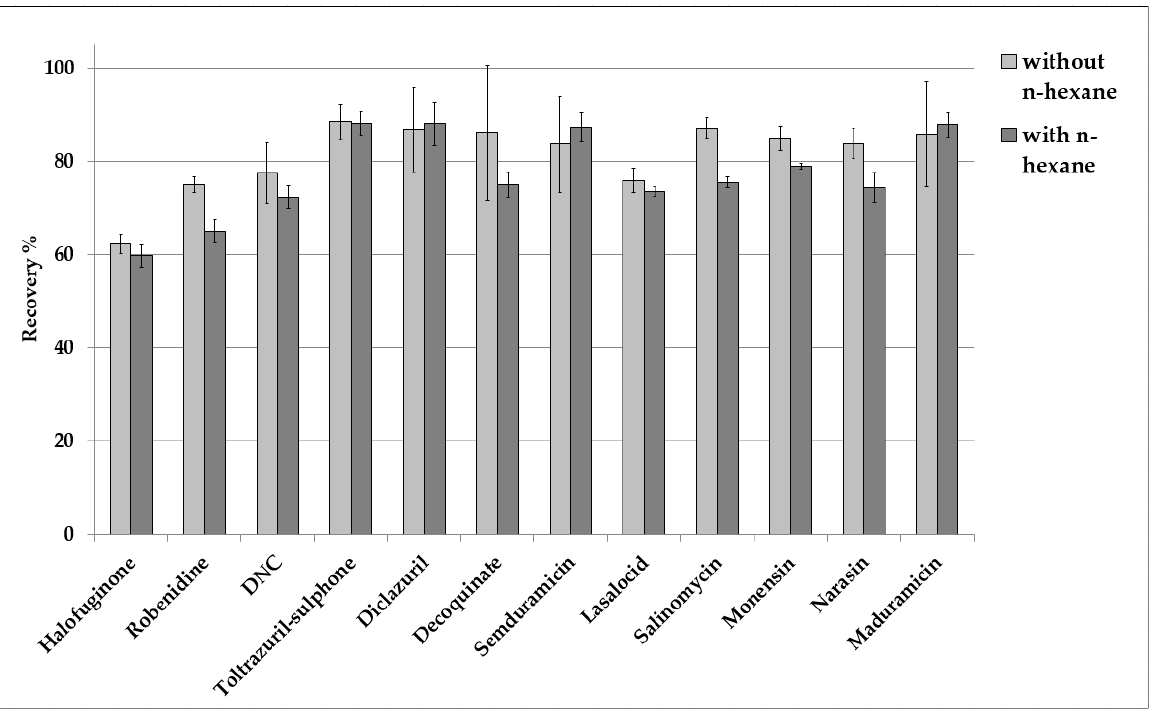
Figure 3. Recoveries derived by the use of n -hexane (defatting) in egg samples ( n = 8 per experiment) spiked at 33.3 µg kg − 1 .